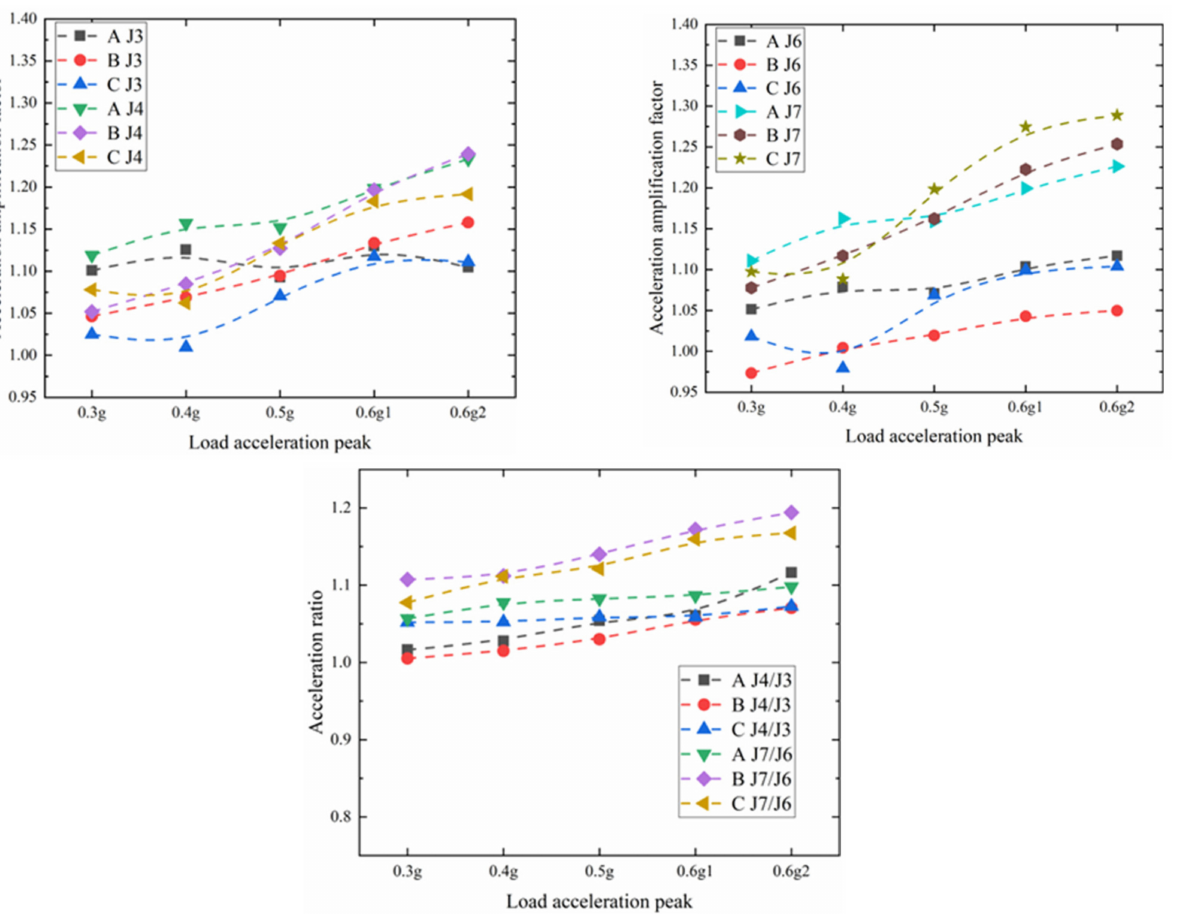
Figure 17. Comparison of three groups of acceleration amplification